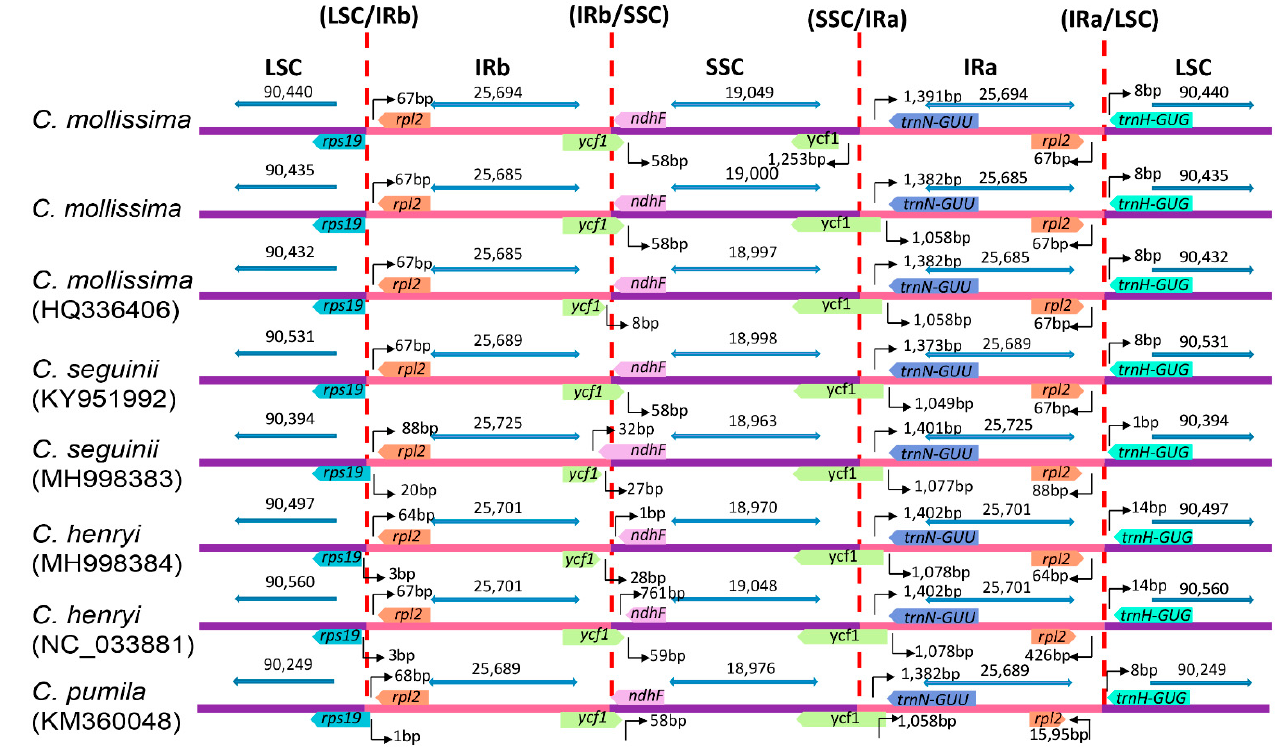
Figure 2. Overview and comparison of the border regions of the cp genomes of C. mollissima , C. seguinii , C. henryi , and C. pumila . The black, angled arrows indicate the size in base pairs of the border genes, the numbers over the blue arrows indicate the size of LSC, IRb, IRa, and SSC, respectively. The gene names show the genomic location of the transitions between major structural elements.